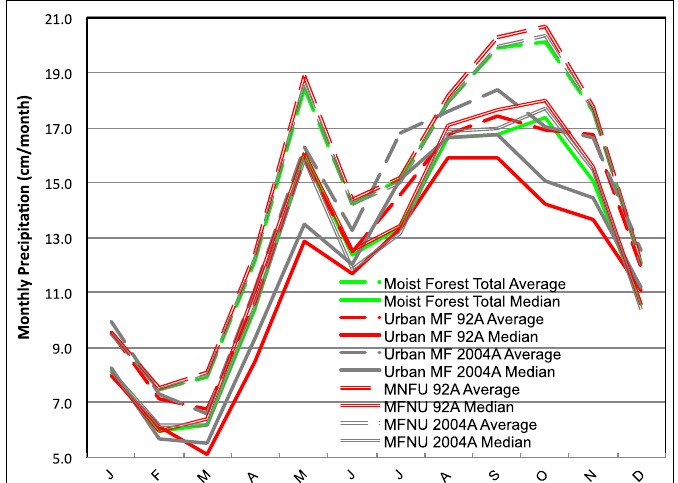
Figure 8. Monthly average and median precipitation for the moist forest urban A and